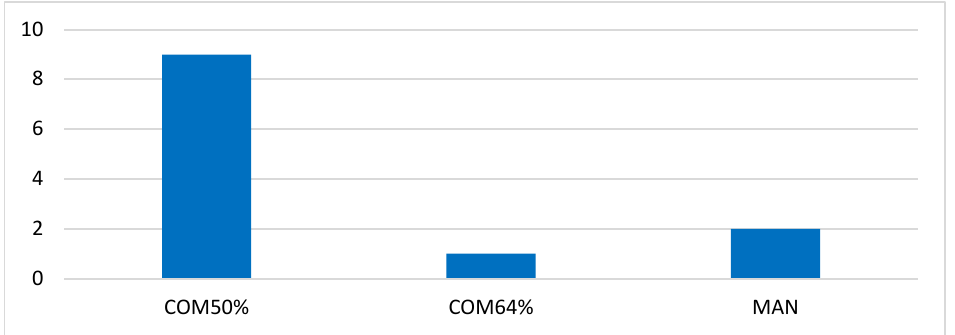
Figure 3. Results of sensory analysis—method of preference evaluation. MAN—raw chocolate, COM 64%—classic bitter chocolate 64%, COM 50%—light bitter chocolate 50% (COM 50%)